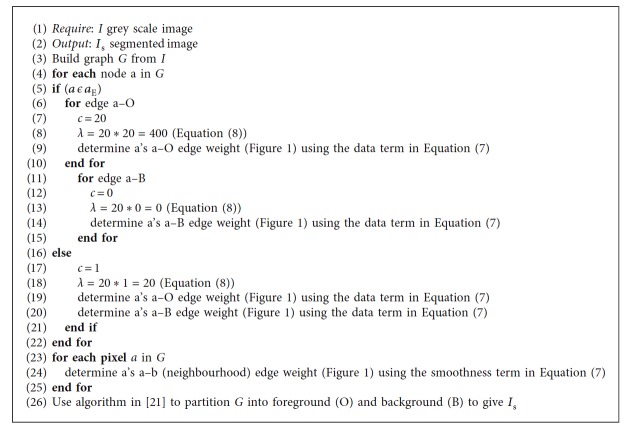
Cell Segmentation using Equation (7).